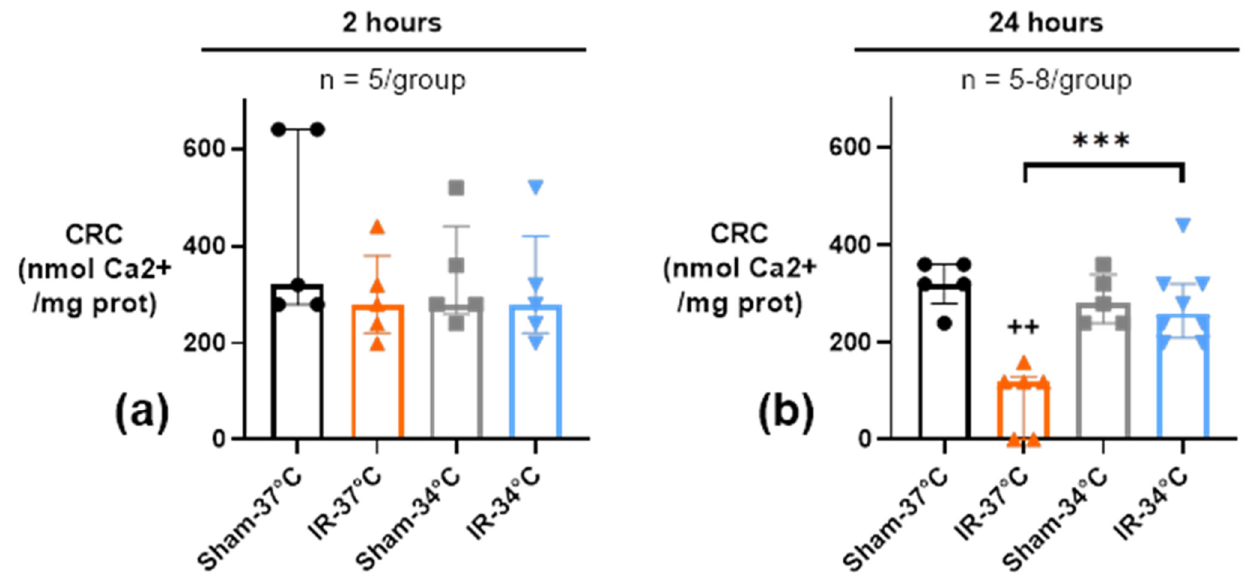
Figure 3. Calcium retention capacity (CRC) in kidney mitochondria after 20 min of bilateral renal ischemia where the mice body temperature was maintained at normothermia (IR-37 ◦ C) or at mild therapeutic hypothermia (mTH) (IR-34 ◦ C), and 2 h ( a ) or 24 h ( b ) of reperfusion, or after a Sham procedure with the same body temperature (Sham-37 ◦ C and Sham-34 ◦ C). Renal ischemia-reperfusion did not have any effect on CRC 2 h after reperfusion, but CRC was significantly altered at 24 h, whereas mTH prevented this decrease and preserved CRC. Data are presented as median with interquartiles. *** p < 0.001, Mann–Whitney test. ++ p < 0.01 vs. Sham-37 ◦ C, Mann–Whitney test.